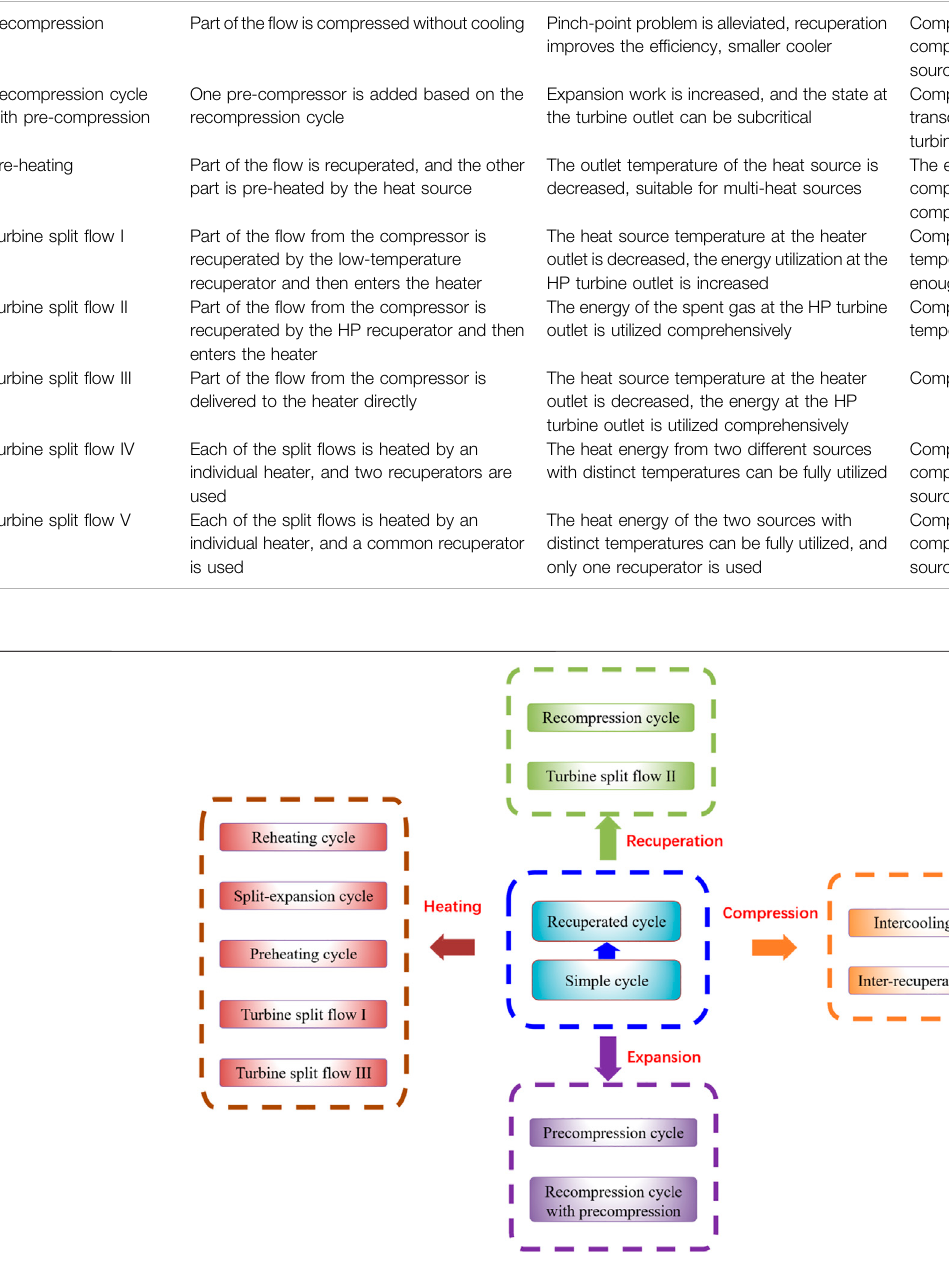
TABLE 5 | Comparison of split- fl ow sCO 2 cycles. Cycle